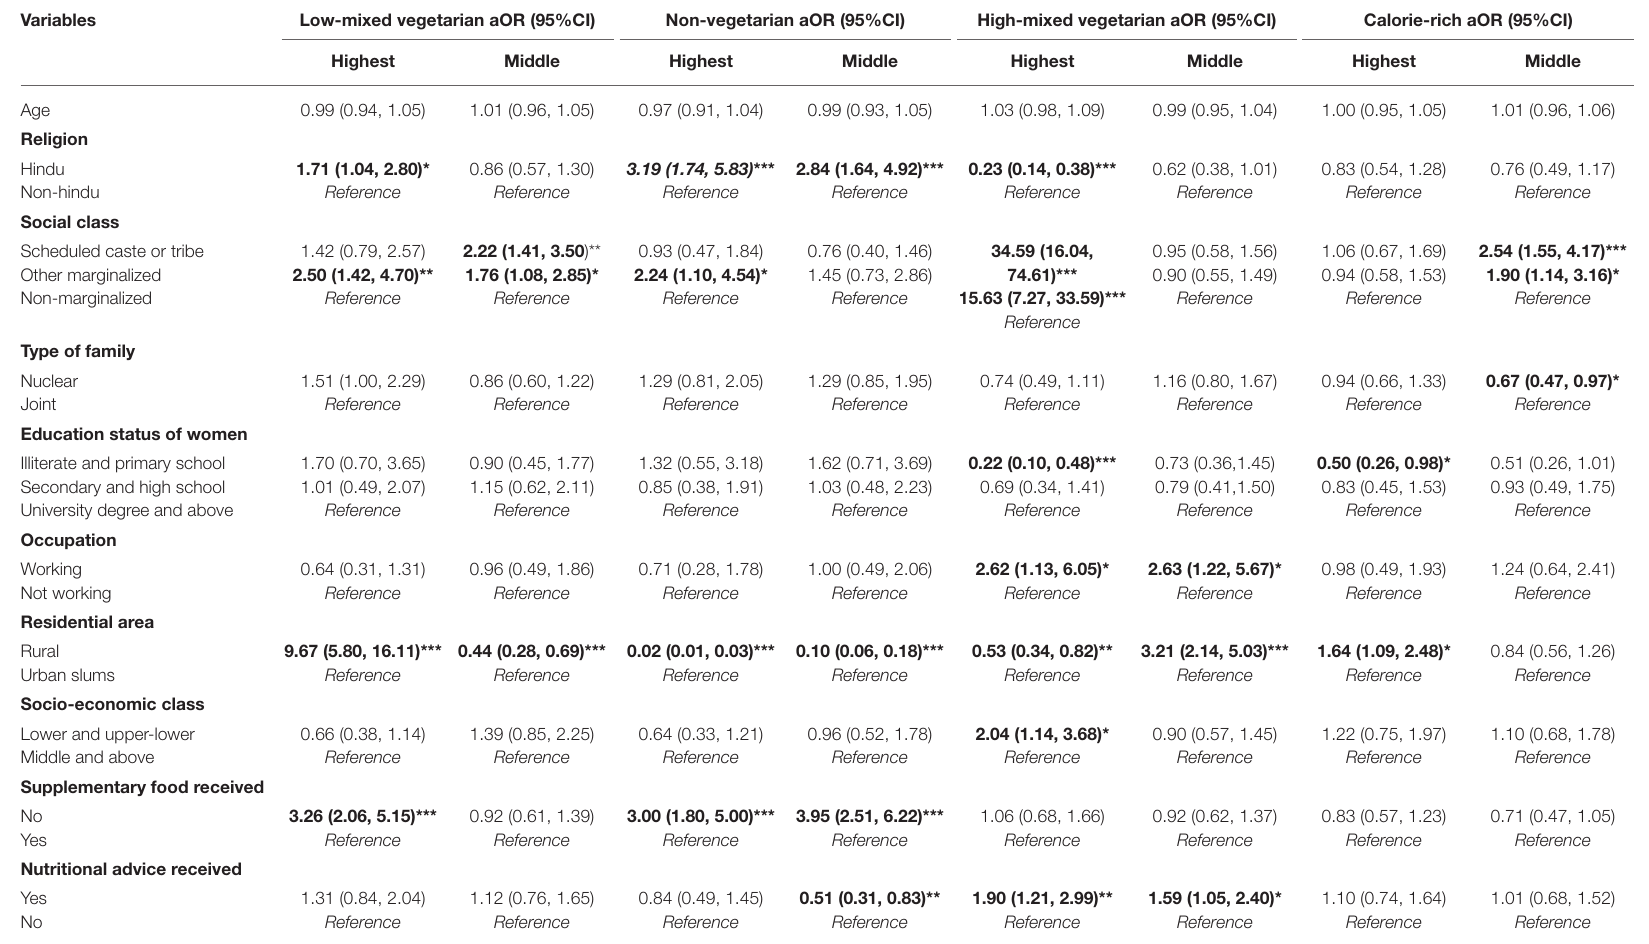
TABLE 4 | Adjusted multinomial logistic regression for the dietary patterns’ associations with socio-demographic variables and access to nutrition services among women ( n = 922). Variables